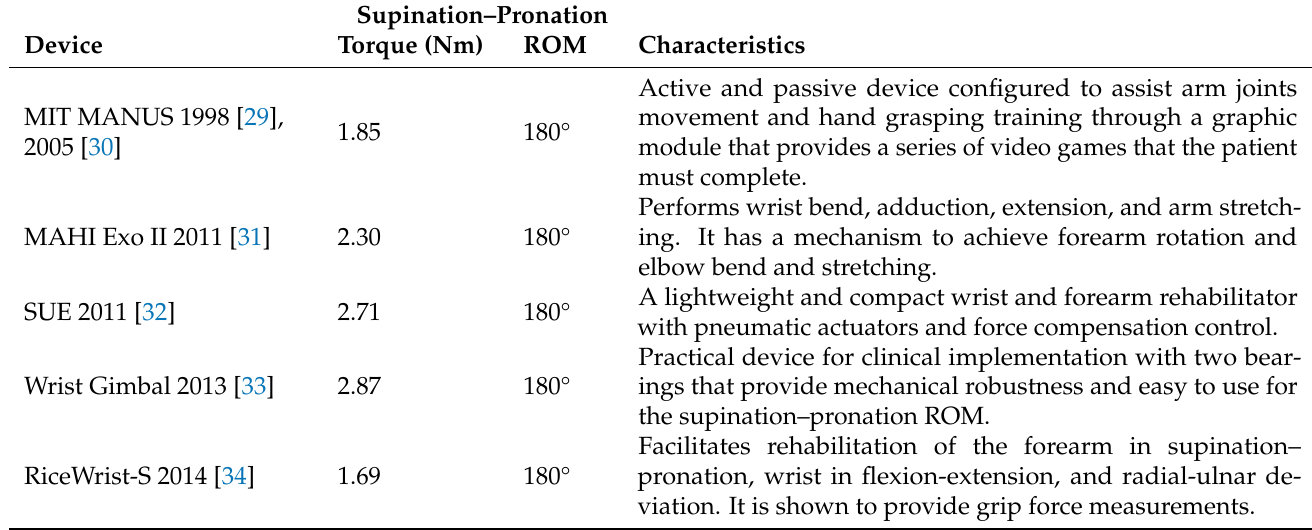
Table 1. Characteristics of wrist–forearm rehabilitation